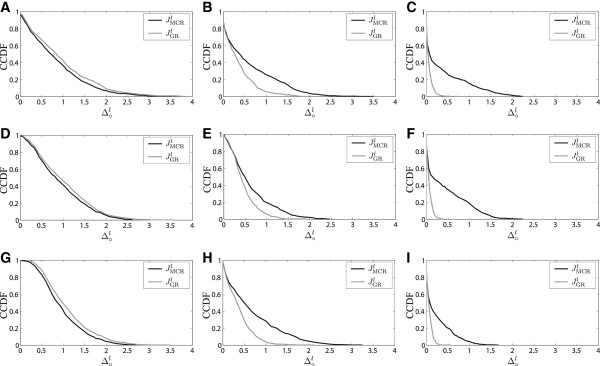
Empirical CCDF ofΔ∘l for different suboptimal intervention policies across randomly generated PBNs with four genes.(A) (κ,ε)=(0.1,0.0). (B) (κ,ε)=(1.0,0.0). (C) (κ,ε)=(5.0,0.0). (D) (κ,ε)=(0.1,0.1). (E) (κ,ε)=(1.0,0.1). (F) (κ,ε)=(5.0,0.1). (G) (κ,ε)=(0.1,0.25). (H) (κ,ε)=(1.0,0.25). (I) (κ,ε)=(5.0,0.25).